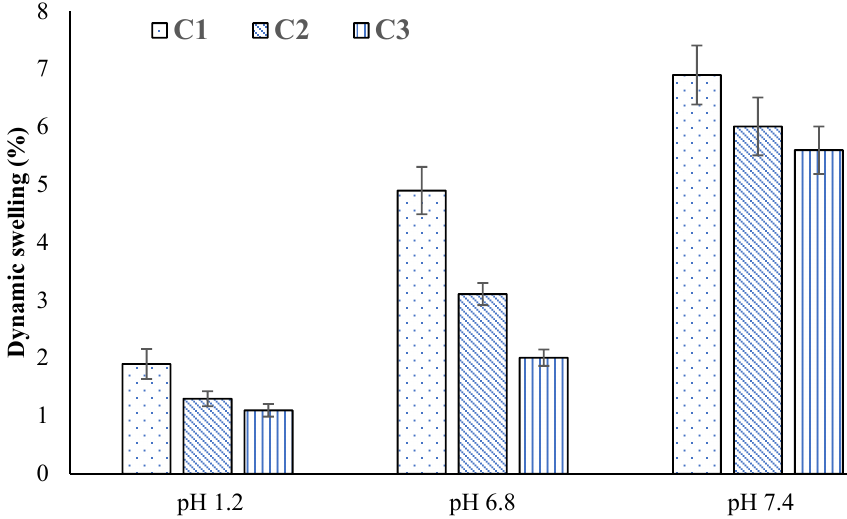
Figure 5. Effect of AA on equilibrium swelling of 5-FULH.